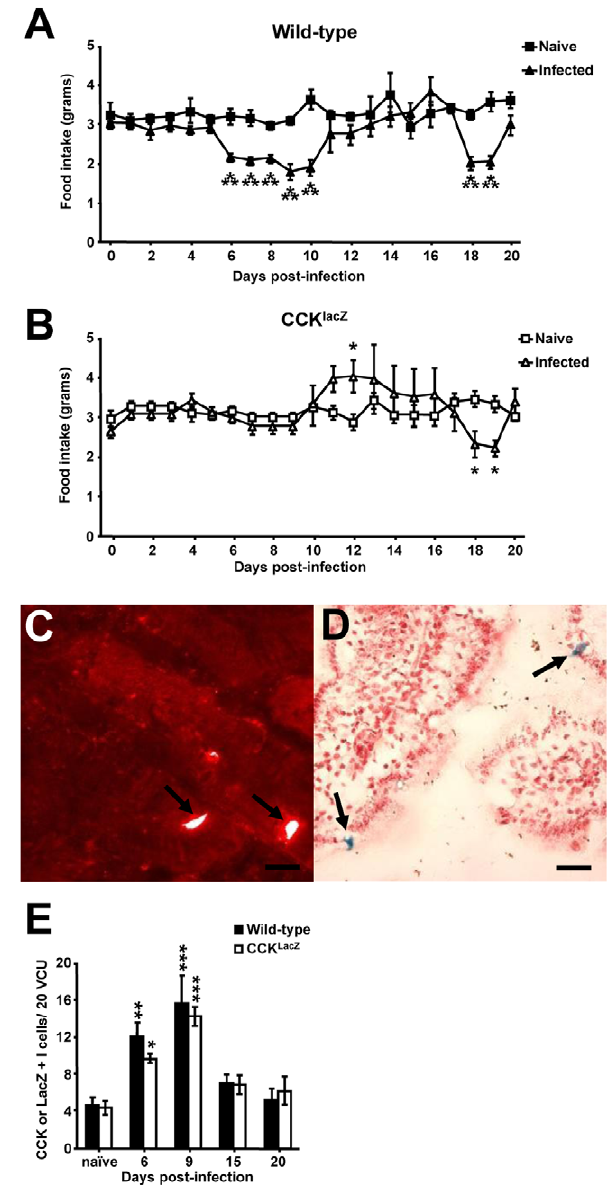
Figure 1. T.spiralis induced enteritis and peripheral myositis produces a CCK dependent and independent bi-phasic hypo- phagia. Food intake of naı¨ve and infected wild-type ( A ) and CCK lacZ ( B ) mice, derived via weighing chow daily. Representative CCK ( C ) and lacZ ( D ) I-cell staining from day 9 p.i. wild-type and CCK lacZ duodenum respectively. Black arrows indicate I-cells. Black bar=100 m m. ( E ) Number of CCK/LacZ positive I-cells/20 VCU in wild-type and CCK lacZ mice as determined from immunohistochemistry or immunofluores- cence respectively. Data (n=8–10 mice/group) from two independent experiments. *, P , 0.05; **, P , 0.01; or ***, P , 0.005 between naı¨ve and infected groups, error bars represent SE of means.